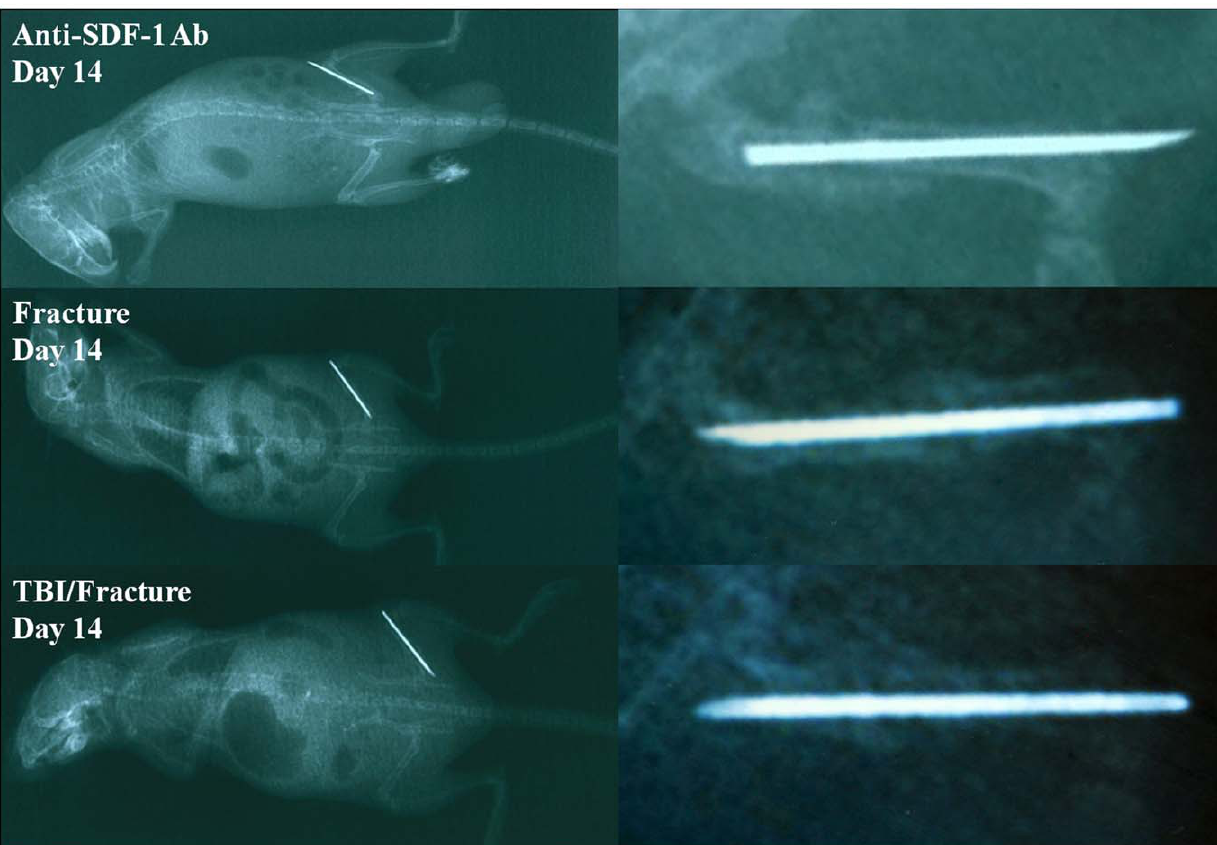
Figure 1. X-ray radiographs of fractured femur in fracture and TBI/fracture groups. At 14 days after fracture, the fracture line was visible in all groups. The callus became dense and callus formation at the fracture site in TBI/fracture group occurred more rapidly than those of the fracture group, whereas callus formation was minimal by the inhibition of SDF-1.